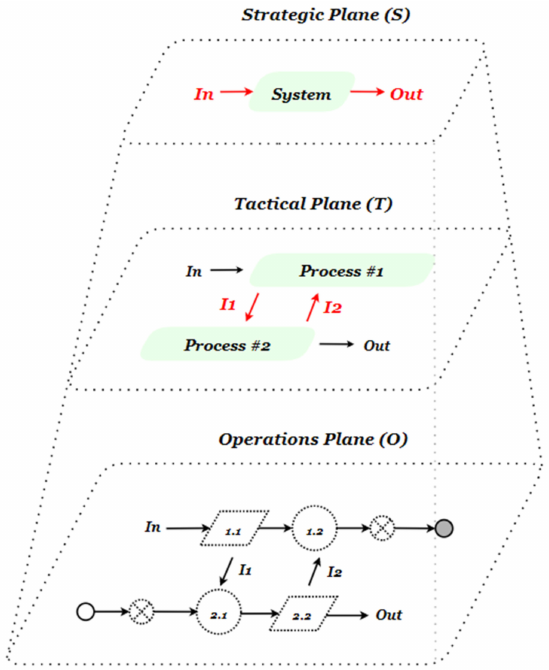
Figure 7. Layered template for Modelling Abstraction